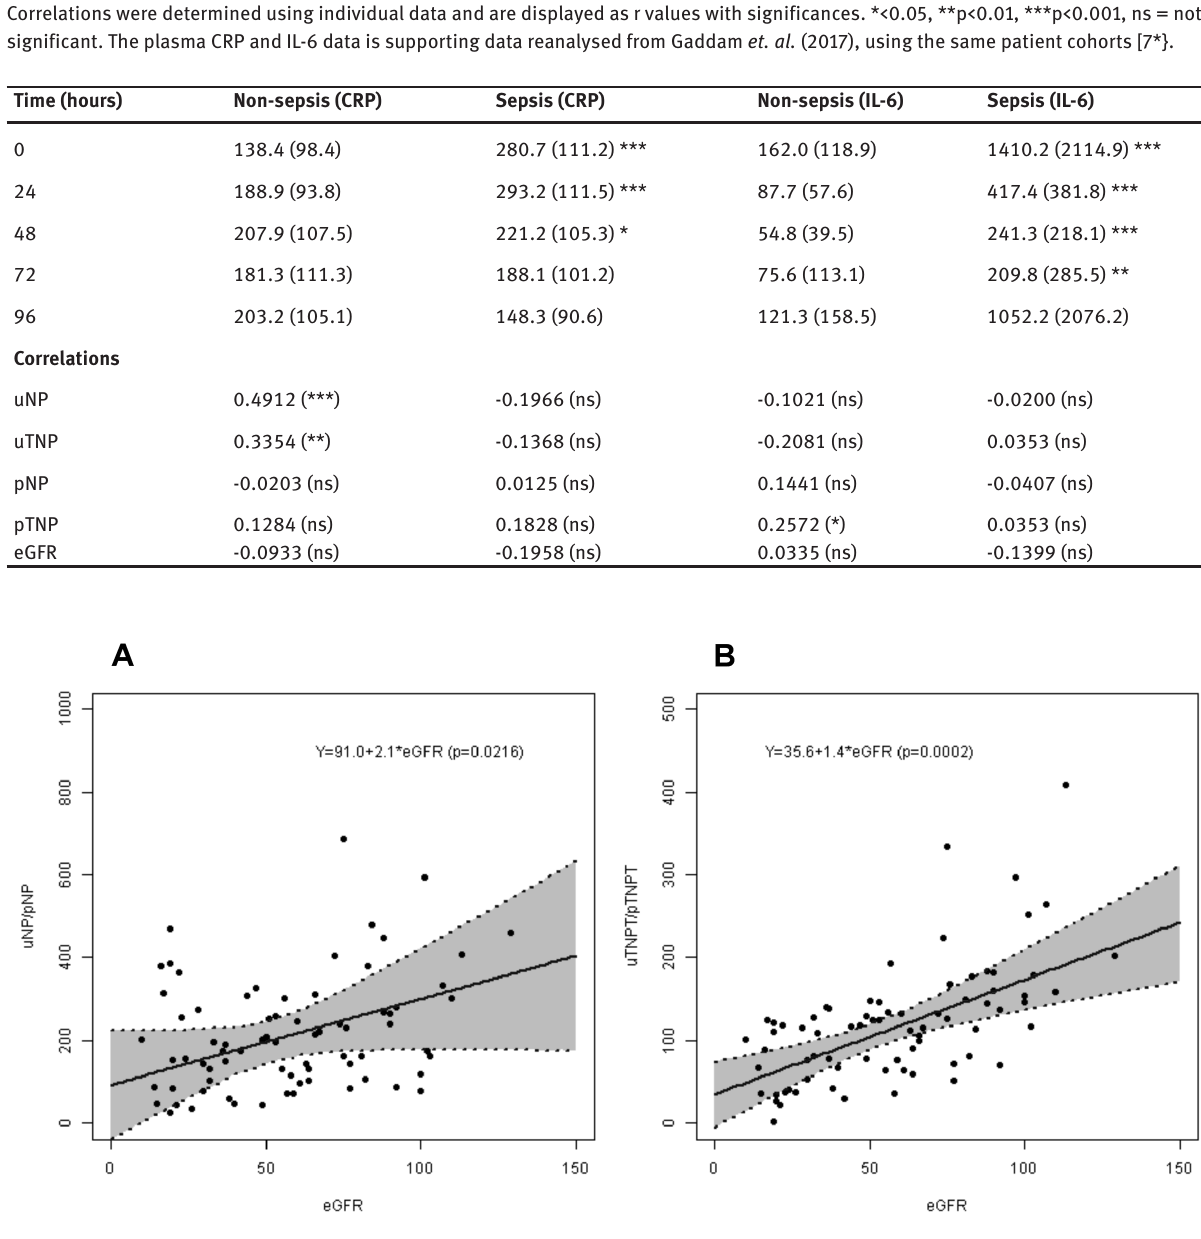
Figure 6: uNP over pNP correlation with eGFR (A) and uTNP over pTNP correlation with eGFR (B) for sepsis patients. The uNP over pNP ratio significantly correlates to eGFR (p<0.02) with an increasing ratio to increasing eGFR trend. uTNP over pTNP significantly correlates to eGFR (p<0.0002) with the trend demonstrating an increased ratio with increasing